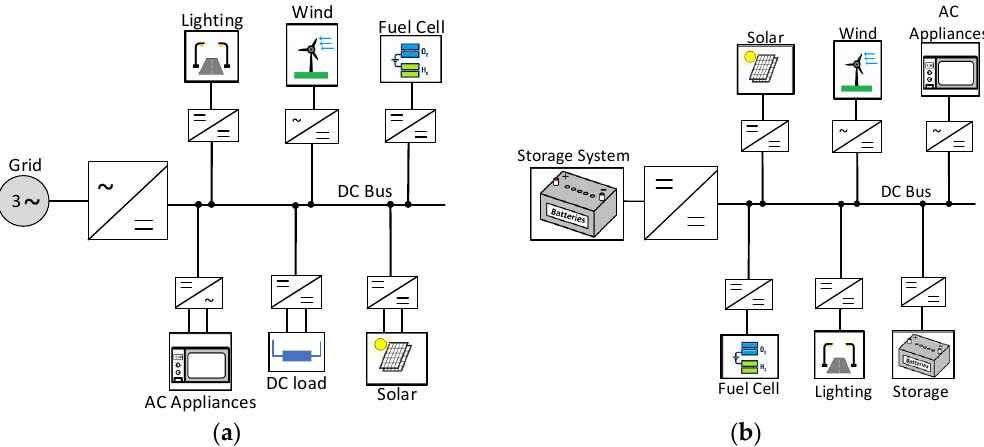
Figure 1. A schematic of typical example of the single bus topology: ( a ) connected to the grid and ( b ) operating in island mode.